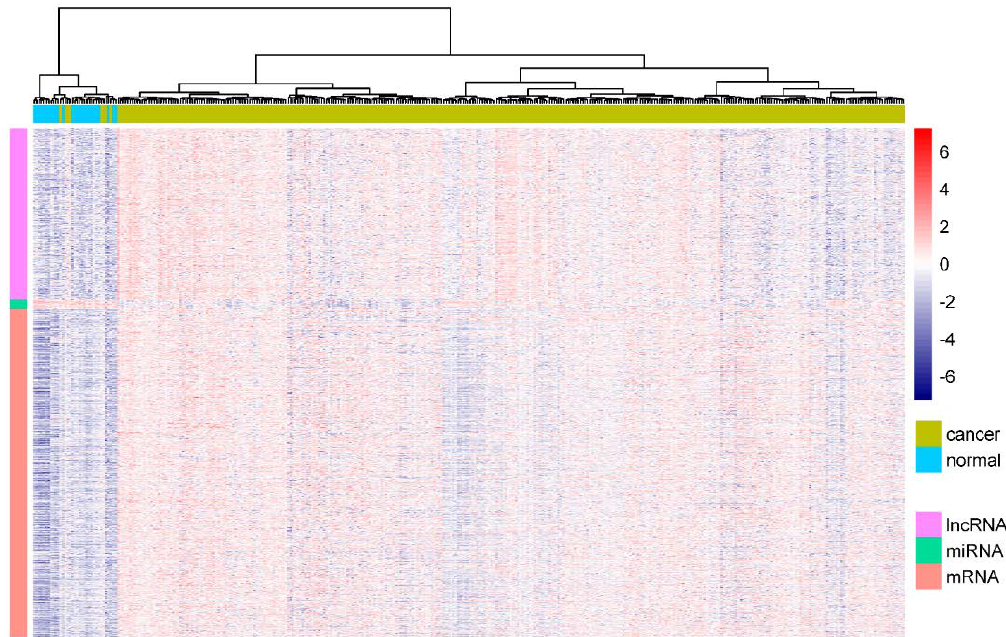
Figure 1. The heatmap of lncRNAs (DELs), mRNAs (DEMs), and miRNAs (DEMis) in gastric cancer (GC). The samples were represented in columns, and the genes were represented in rows, with different colors. The expression value for each row was normalized by the z-score. Red indicates high relative expression and blue indicates low expression of genes as shown in the scale bar.